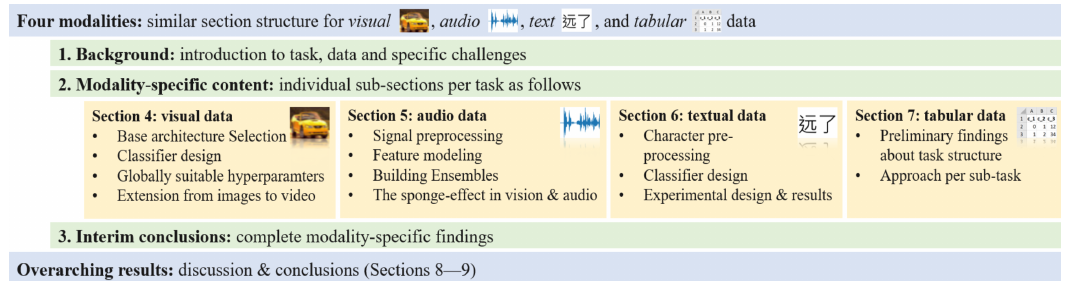
Figure 2. Study design: we organize the main sections according to data modality, using a unified structure with a few task-specific sub-sections. Only modality-specific findings are presented